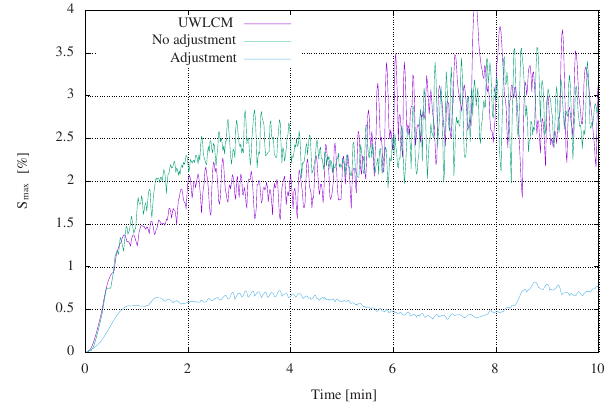
Figure 11. Evolution of the maximum supersaturation in the do- main for UWLCM simulations (purple line) and Twomey scheme with (blue line) and without (green line) adjustment for unphysical supersaturation fluctuations. Data are plotted at every model time step with 200 super-droplets in UWLCM and 200 division in the model with the Twomey